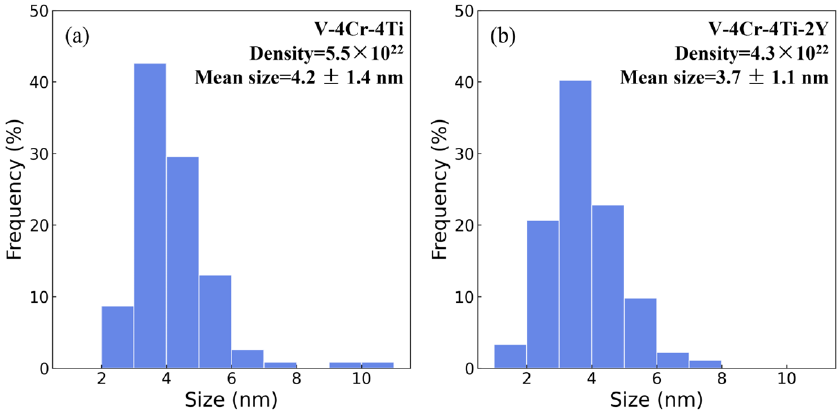
Figure 5. Size distribution of irradiation-induced dislocation loops in ( a ) V-4Cr-4Ti alloy and ( b ) V-4Cr-4Ti-2Y alloy. Table 2. Number density and mean size of dislocation loops in V-4Cr-4Ti and V-4Cr-4Ti-2Y alloys.